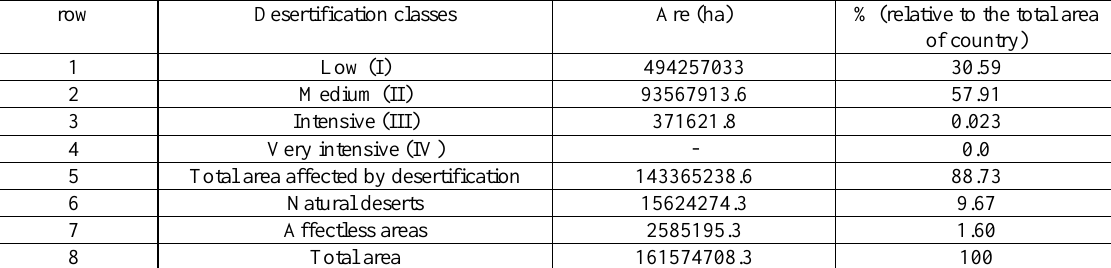
Table 1. Classification of desertification intensity